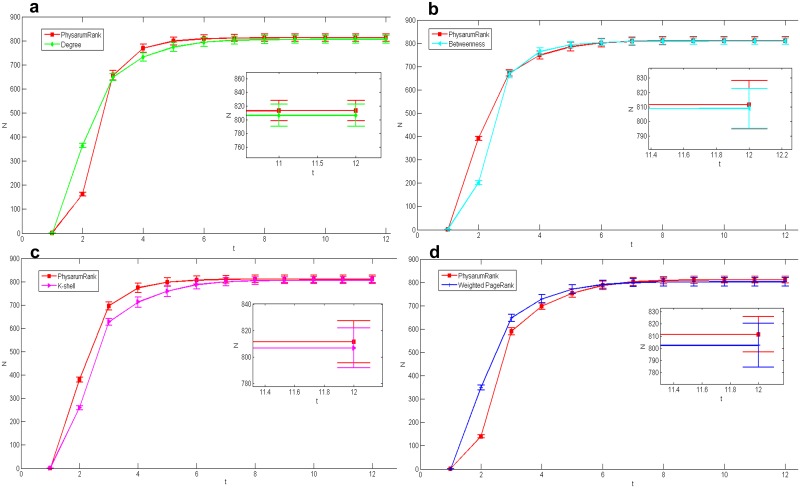
Comparison of epidemic spreading efficiency among different measures when L = 20, in US airports network.Each result N is obtained by averaging over 100 implementations with α = 0.2 and β = 1. (a):PhysarumSpreader vs Degree, n = 11. (b):PhysarumSpreader vs Betweenness, n = 17. (c):PhysarumSpreader vs K-shell, n = 16. (d):PhysarumSpreader vs Weighted PageRank, n = 10.